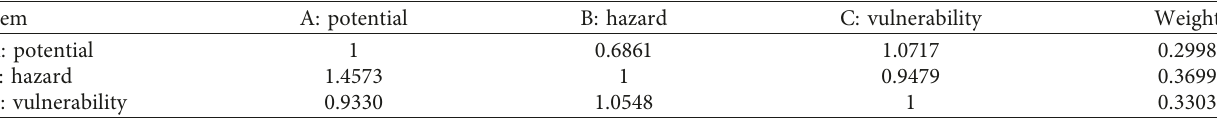
Table 5: Relative importance of the evaluation